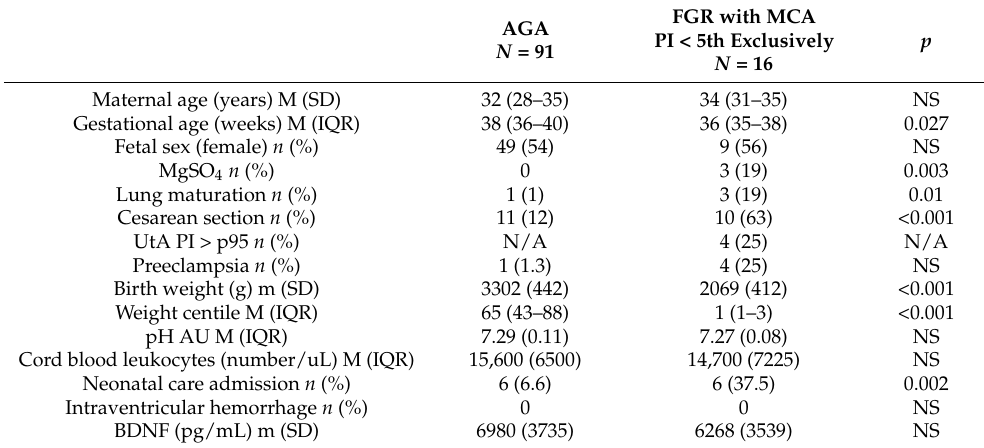
Figure 1. BDNF Box plot across study groups. p * is adjusted for gestational age with linear regression. Subgroup analysis to assess the effect of decreased MCA PI on BDNF was performed. Clinical characteristics and differences between both groups are shown in Table 2. BDNF levels showed a downward trend, but no differences were found. AGA fetuses and FGR fetuses with decreased MCA PI showed similar BDNF levels. Within FGR fetuses, no differences were found between fetuses with decreased MCA PI and FGR fetuses with UA PI > 95th percentile (Figure 2). Table 2. Bivariate analysis of maternal and perinatal features between clinical